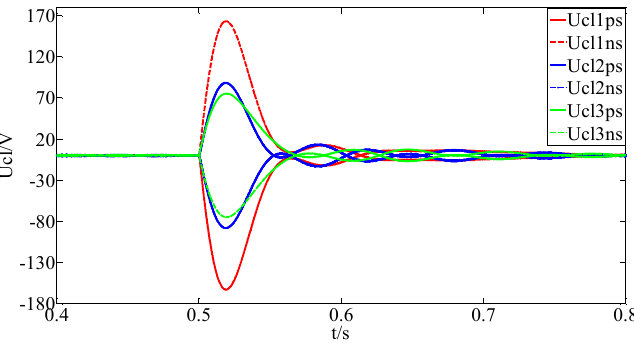
Figure 11. Voltage waveforms of the CLIs with power reversal.